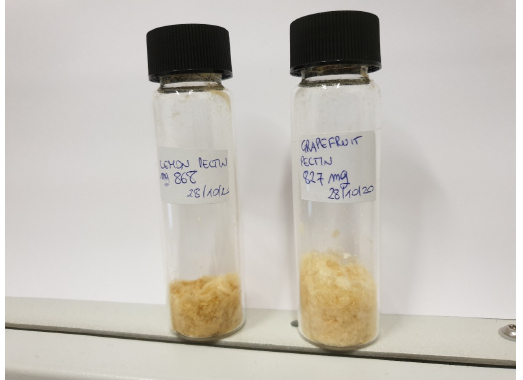
Figure 4. The lemon ( left ) and grapefruit ( right ) IntegroPectin samples analyzed for the volatile content.